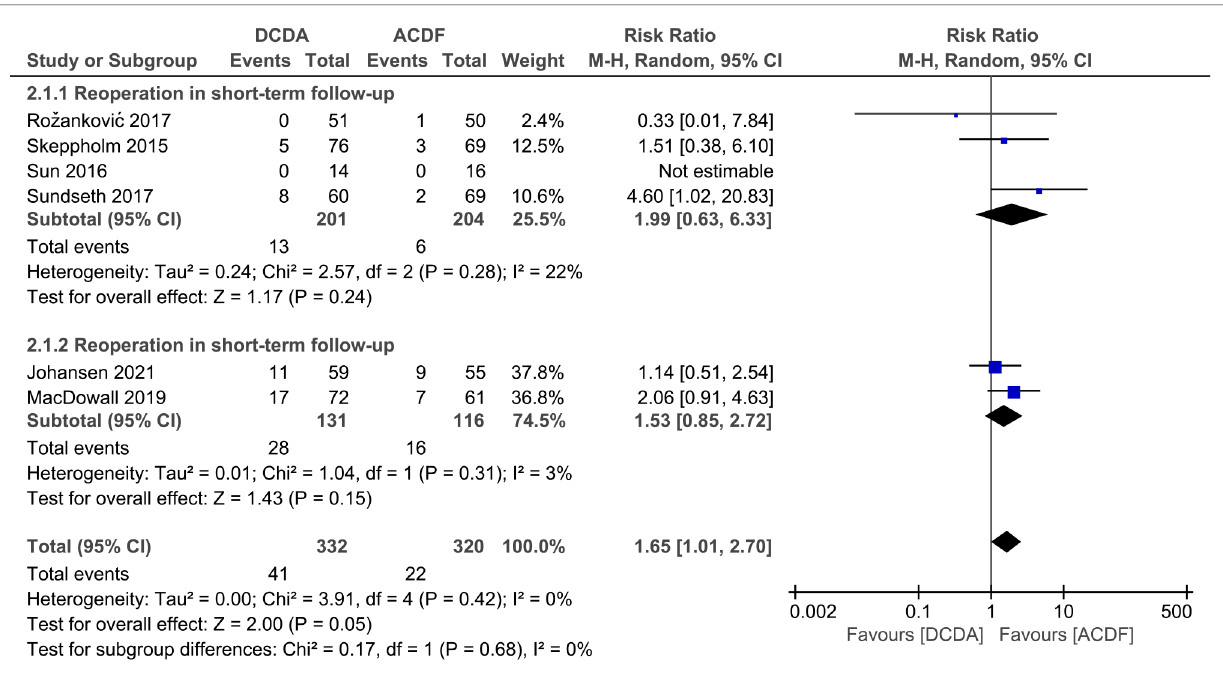
FIGURE 8 Comparison of reoperation between the discover cervical disc arthroplasty (DCDA, “ experimental ” ) group and the anterior cervical discectomy and fusion (ACDF, “ control ” ) group.